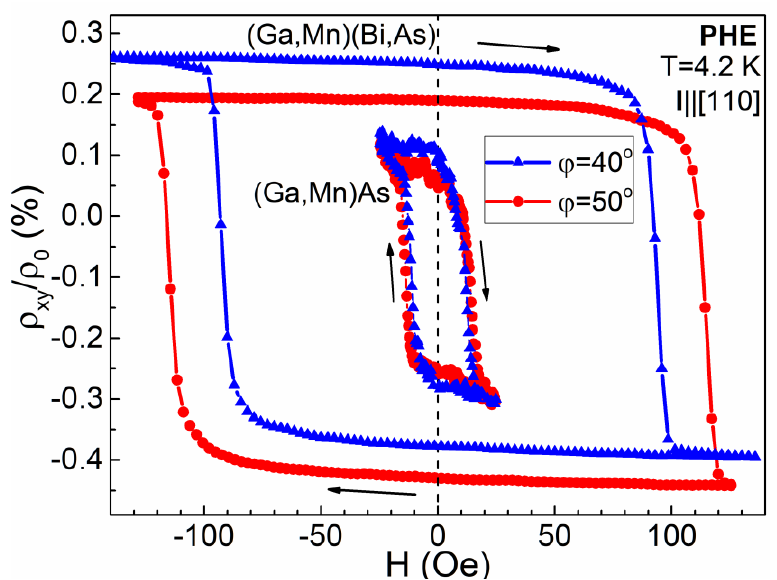
Figure 5. Same as in Figure 3 but measured for the sweeping magnetic field applied at the ϕ angle values of 40° and 50°. The curves for the (Ga,Mn)(Bi,As) Hall-bar are vertically offset for clarity.